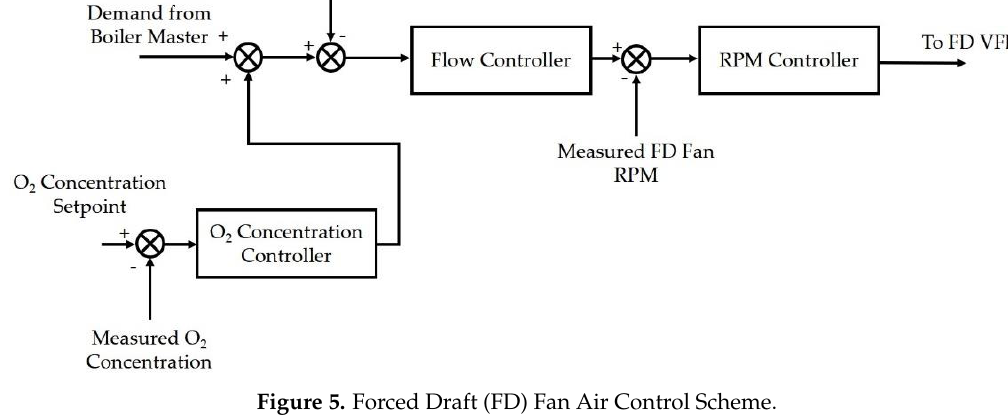
Processes 2018 , 6 , x FOR PEER REVIEW Figure 5. Forced Draft (FD) Fan Air Control Scheme. Figure 5. Forced Draft (FD) Fan Air Control Scheme.